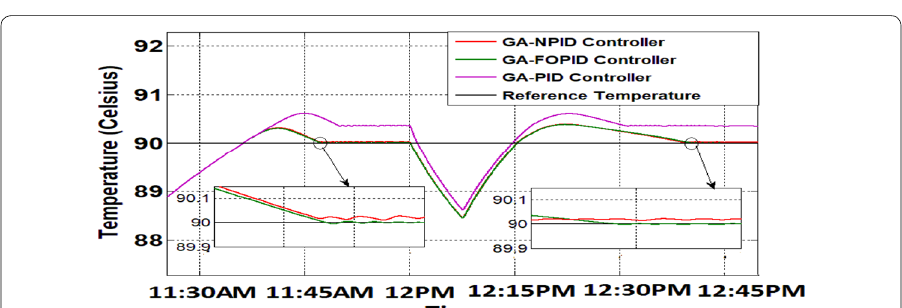
Fig. 13 Temperature response using different controllers with 10% disturbance